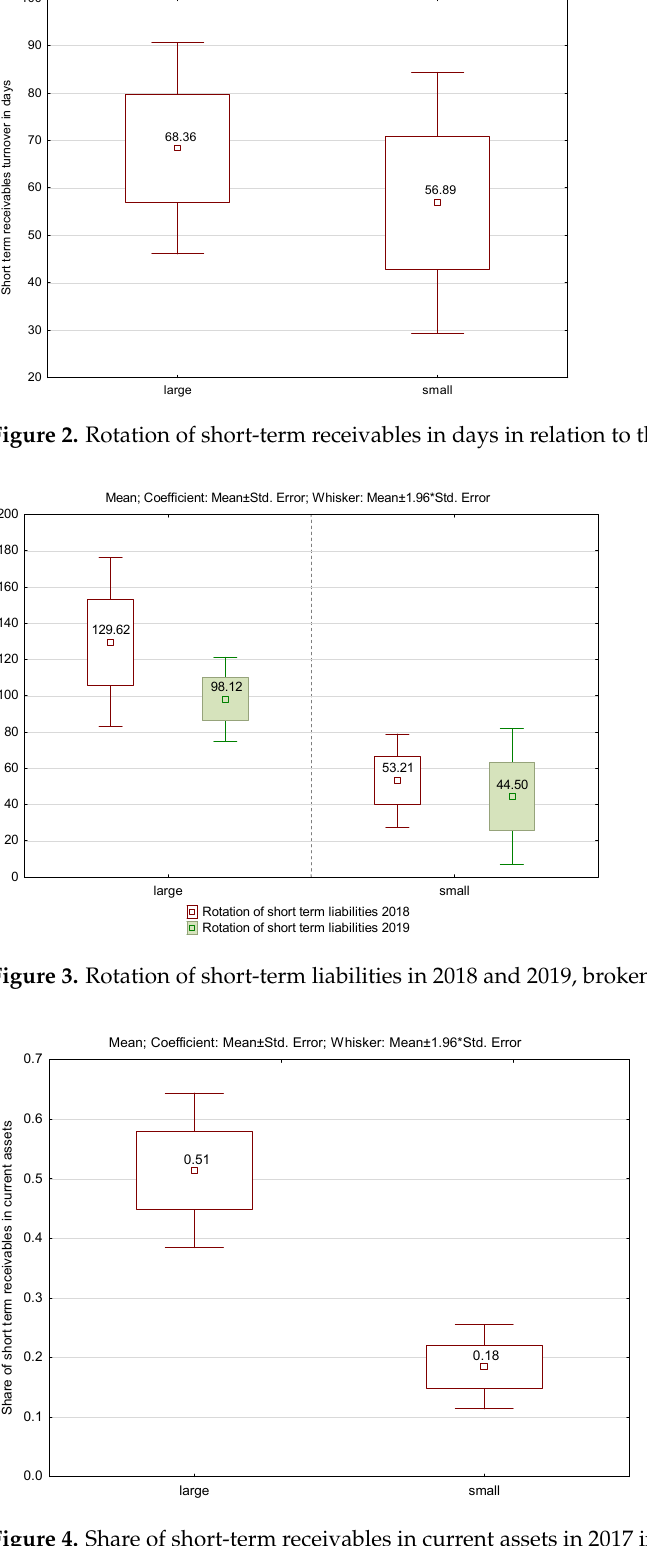
Mean; Coefficient: Mean±Std. Error; Whisker: Mean±1.96*Std. Error